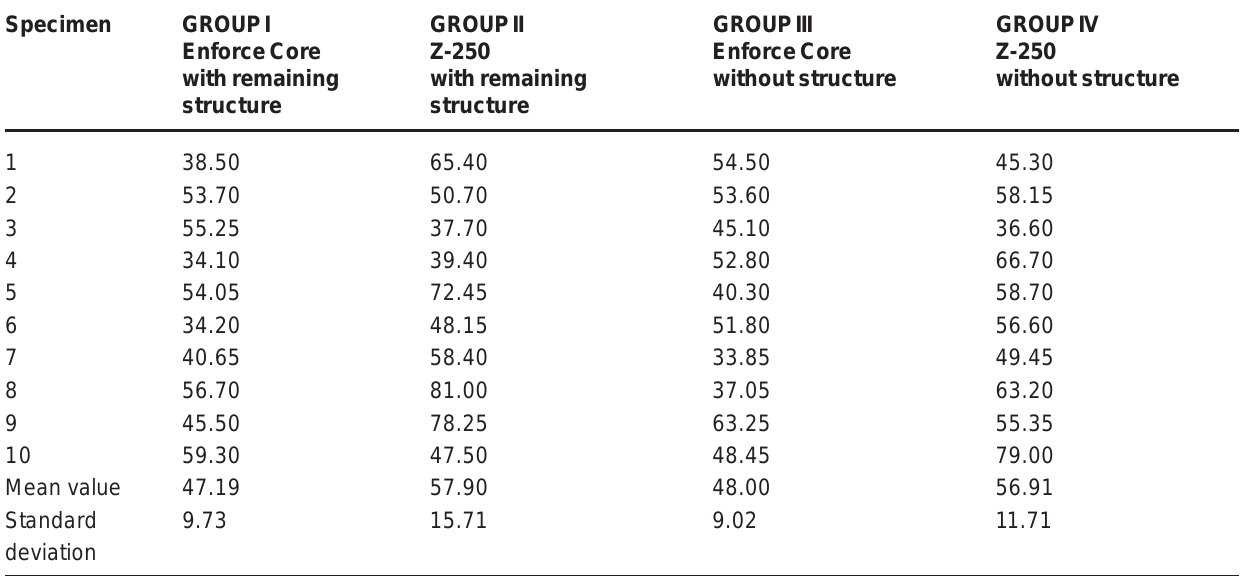
TABLE 1- Individual, mean and standard deviation values for each experimental condition (in Kgf)